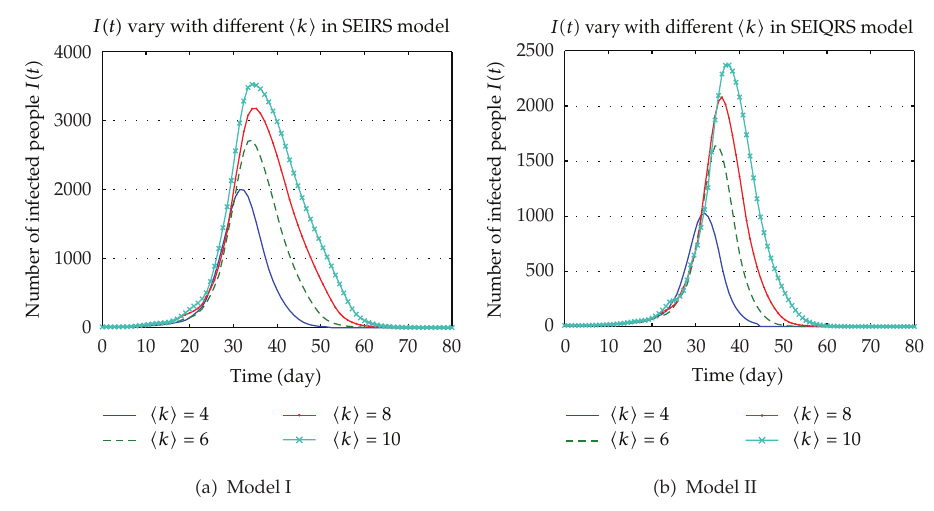
Figure 5: Number of infected people with di ff erent (cid:4) k (cid:5)